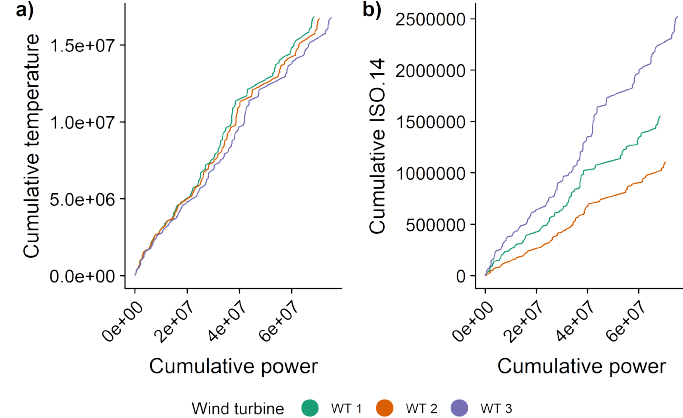
Figure 5. Cumulative values against cumulative active power. ( a ) Temperature. ( b ) ISO.14.